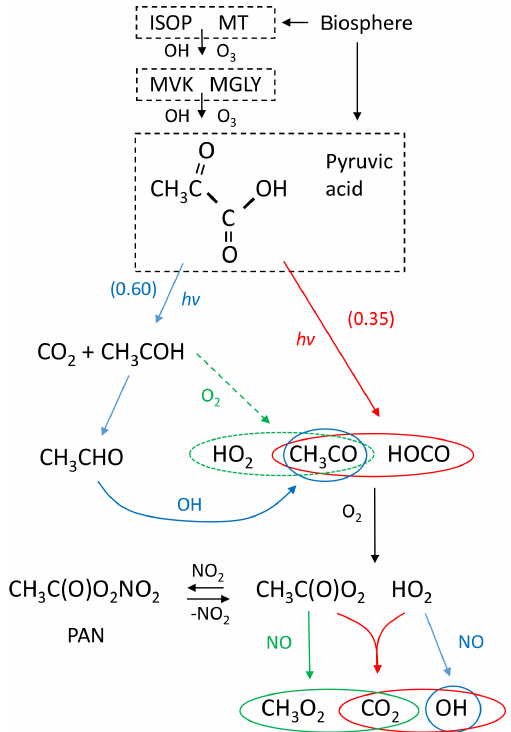
Figure 5. Sources of pyruvic acid and mechanism of formation of CH 3 CHO, HO 2 and CH 3 C ( O ) O 2 during its photolysis. ISOP: iso- prene; MT: monoterpenes; MVK: methyl vinyl ketone; and MGLY: methylglyoxal. Numbers in parentheses indicate branching